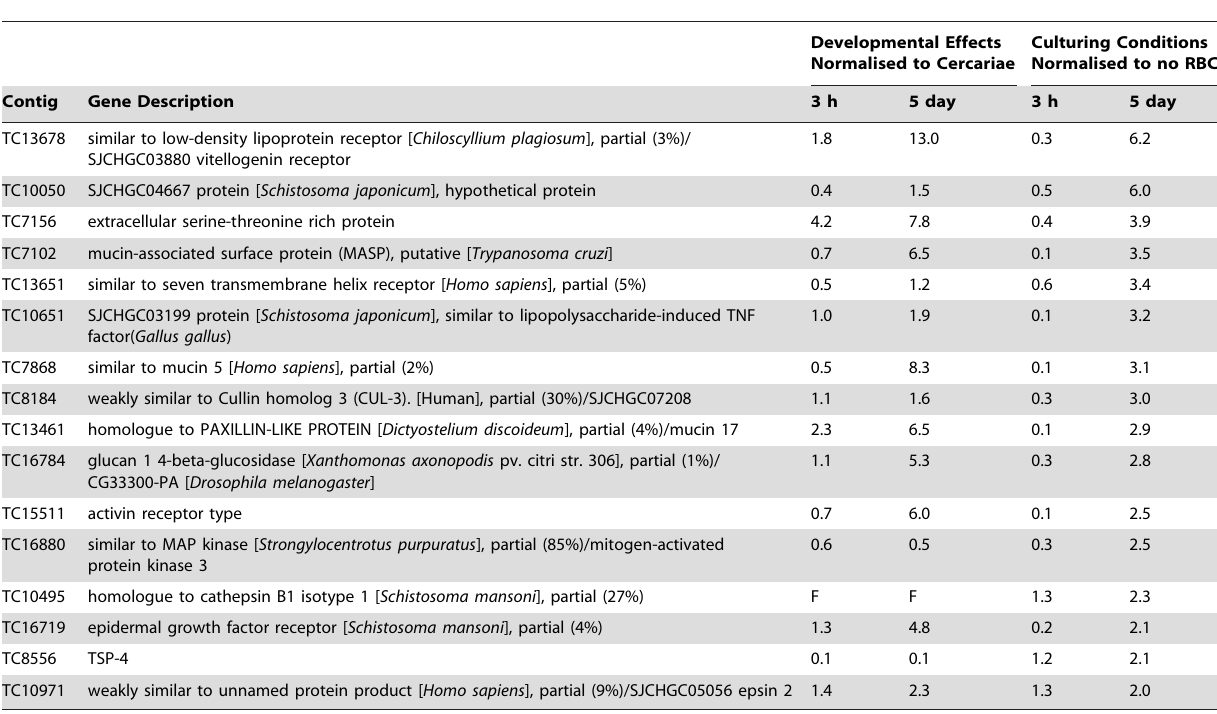
Table 2. Examples of genes that were up-regulated either in schistosomula of S. mansoni cultured for 3 hours or 5 days in the presence of